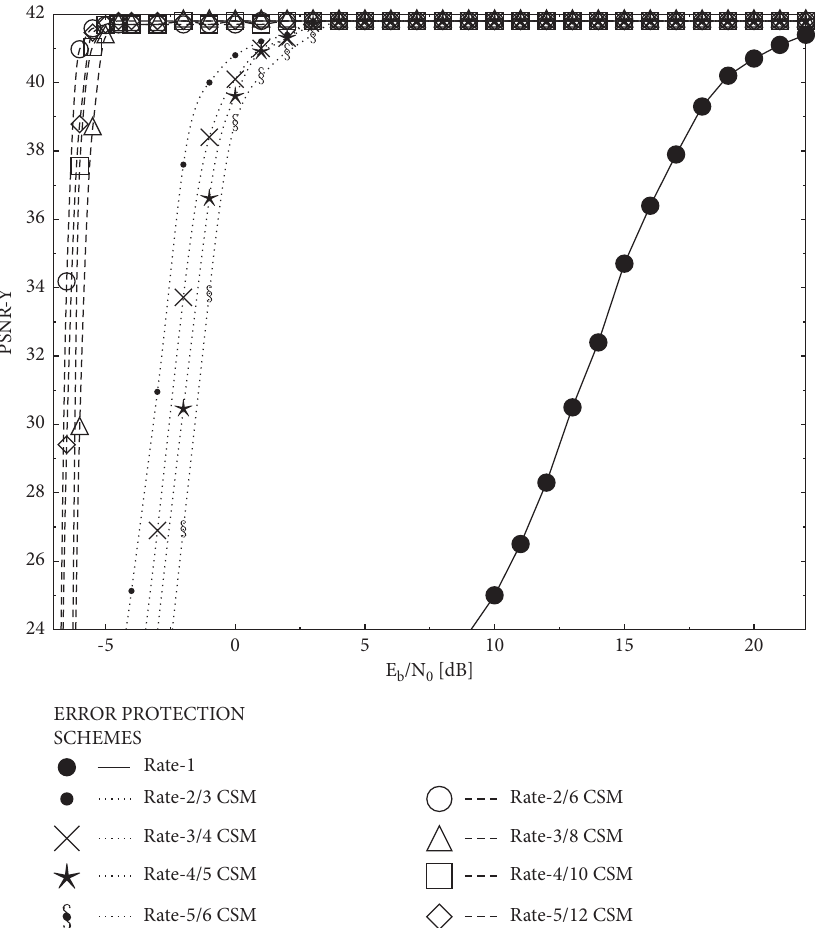
Figure 15: PSNR performance comparison of CSM schemes with Rate-1